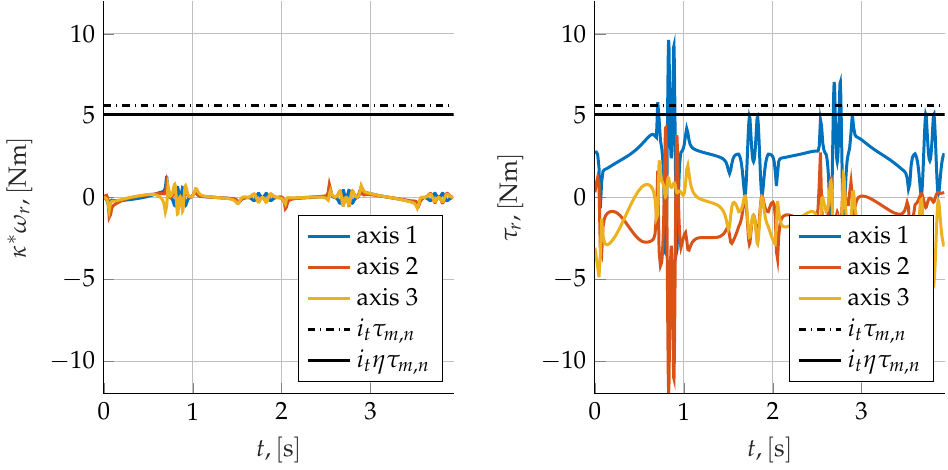
Figure 20. Torques at the output shaft for i t = 7; in the left panel : inertial torques of the motor projected through an ideal transmission; in the right panel the load torques are reported. The black lines represent the rated torque of the motor reduced to the output shaft through an ideal (dashed line) and non-ideal (continuous line)